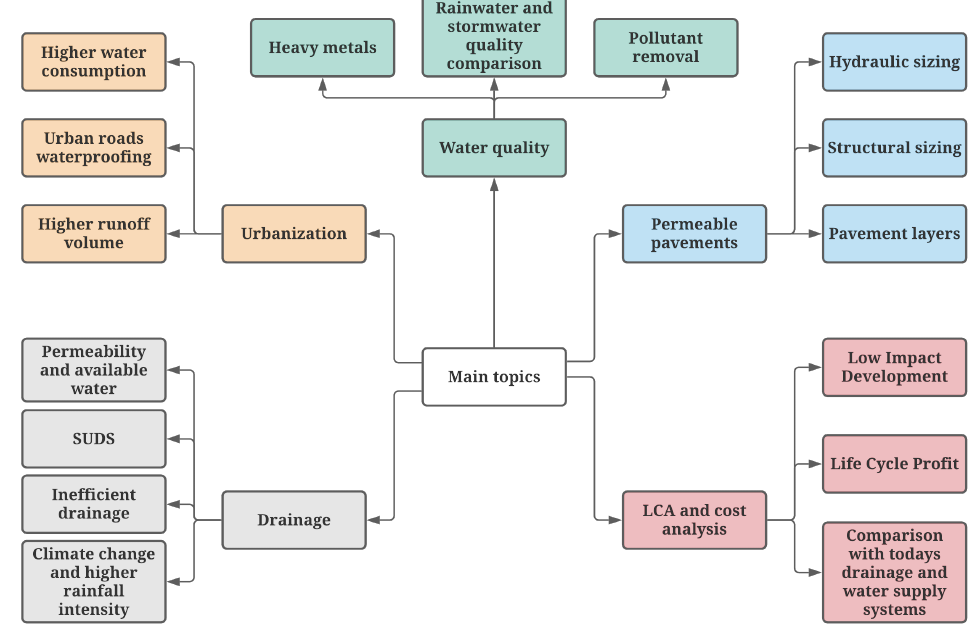
Figure 1. Permeable pavements and rainwater harvesting main research